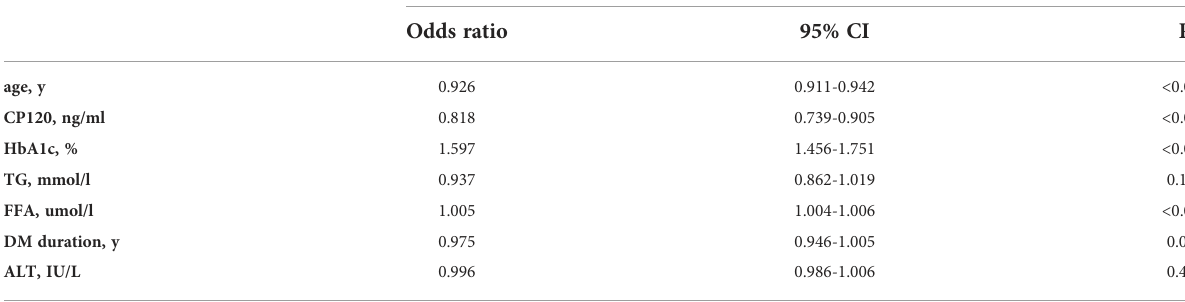
TABLE 3 Multivariable logistic regression of patients with and without ketosis in T2DM.